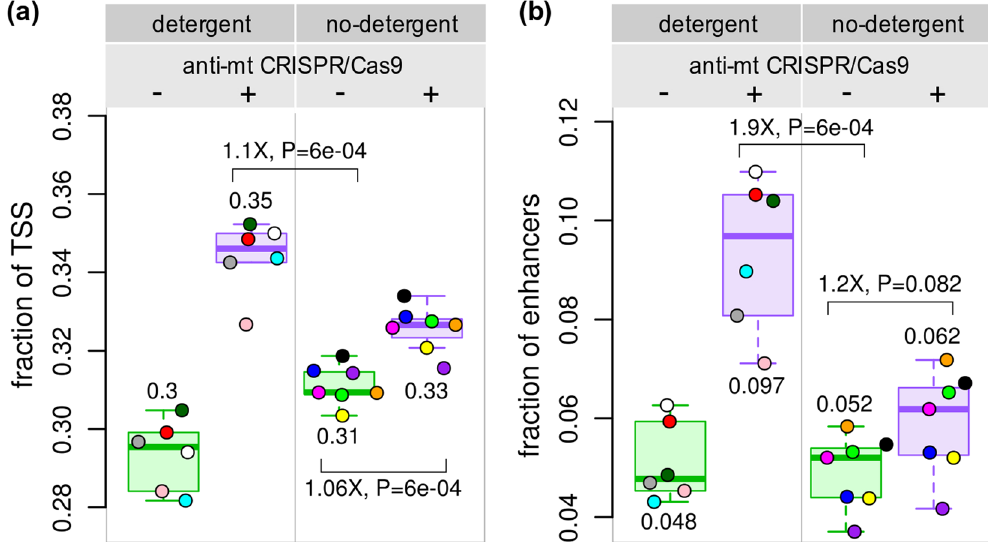
Figure 4. Comparison of the fraction of functional regions overlapping ATAC-seq peaks. ( a ) The fraction of transcription start sites (TSS’s) overlapping an ATAC-seq peak ( + / − 1 kb) was slightly higher in the DT samples than in the ND samples (1.05-fold). ( b ) Treated DT samples identified a greater number of Epigenome Roadmap GM12878 lymphoblastoid cell active enhancers (1.9-fold) than anti-mt CRISPR untreated ND samples. Fold-differences calculated on